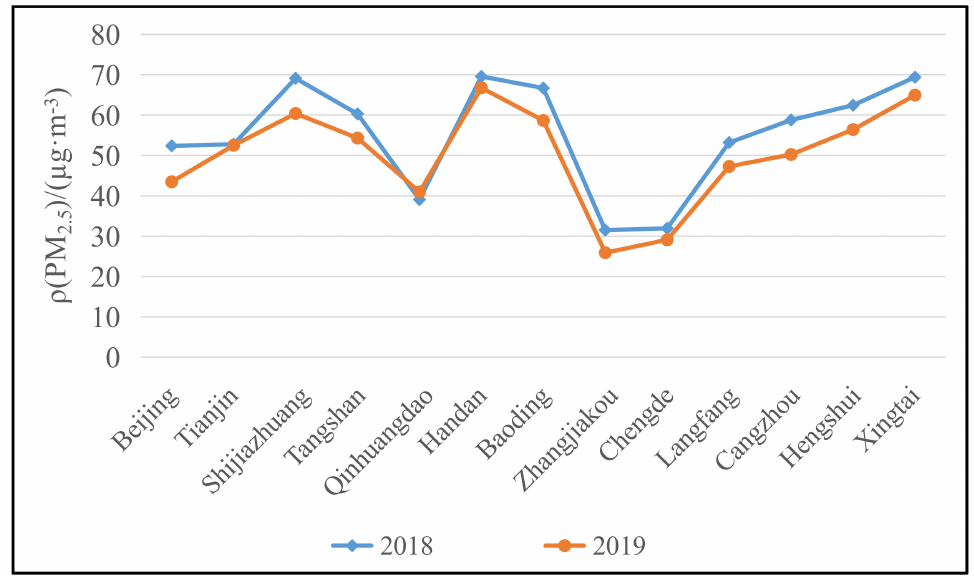
Figure 5. Average annual PM 2.5 concentrations for the major cities of the BTH in 2018 and